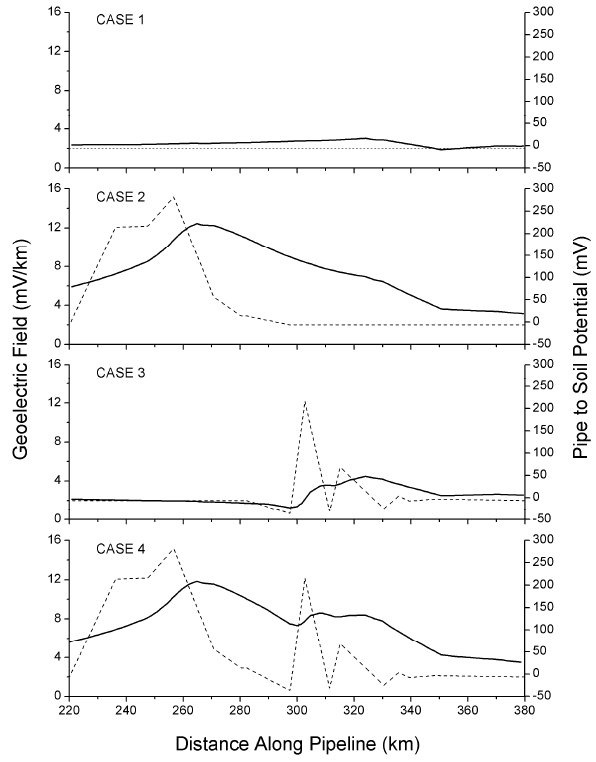
Figure 9. Fig. 9. Modelled PSP variations and calculated non-uniform geo- electric field versus distance along pipeline, as derived from all measured Z yx (45) impedances between: km 235 and km 350 for Case 1; km 245 and km 270 for Case 2; 290 and km 340 for Case 3; and, km 235 and km 350 for Case 4. Solid line represents the pipe-to-soil potential. Dashed line represents the geoelectric field (0.01Hz) – assuming a 1nT variation of the geomagnetic field – along general alignment of pipeline.